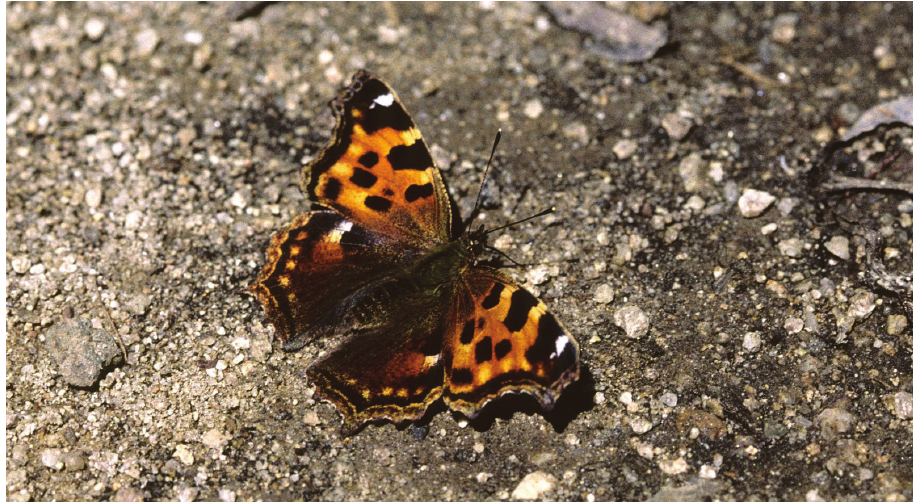
Nymphalis vaualbum . Photo Tom Nygaard